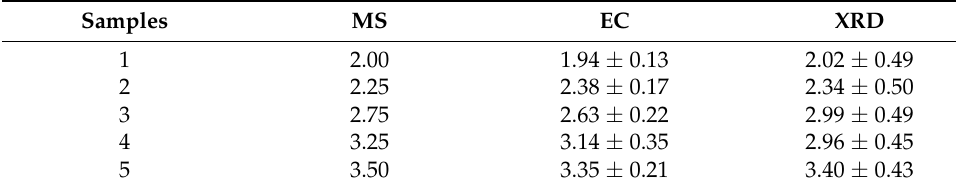
Table 7. Thickness for nickel-plating layers with MS, ED, and XRD techniques ( µ m). Samples